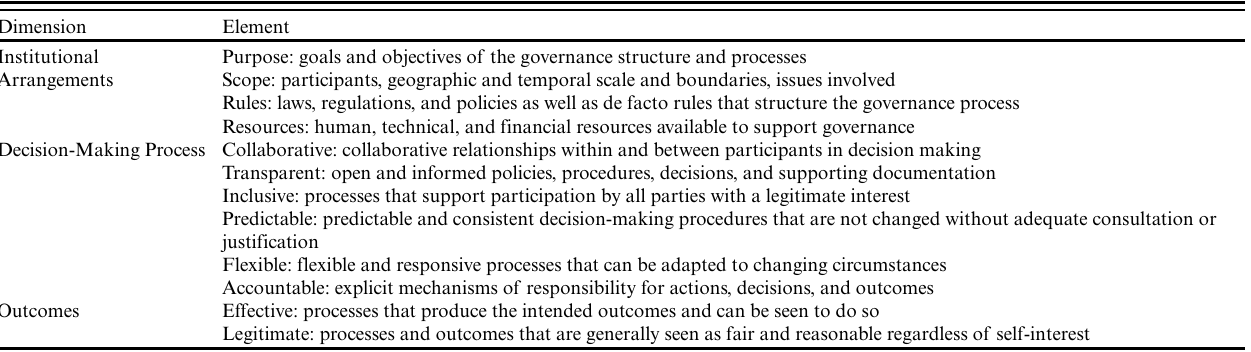
Table 1 . Elements in the governance domain.